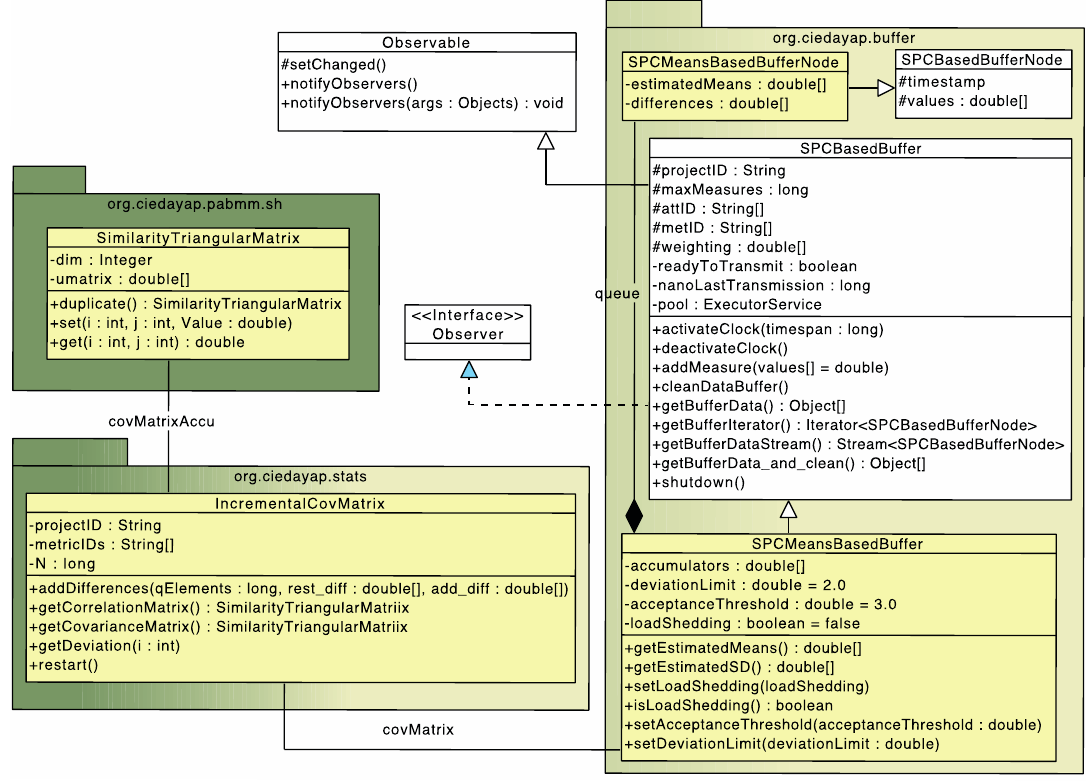
Figure 2. Main classes related to the data buffer with the capacity of estimating